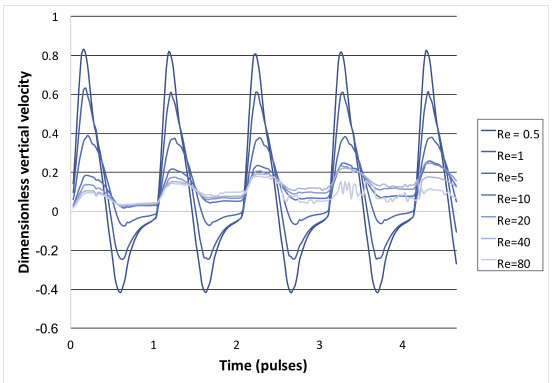
Fig. 8: The spatially averaged dimensionless ver- tical flow upwards over the polyp ( u y ) versus time for five pulse cycles. Re f = 0 . 5 , 1 , 5 , 10 , 20 , 40 , and 80 are shown. Flow velocity is nondimensionalized using the tentacle length and pulse duration.